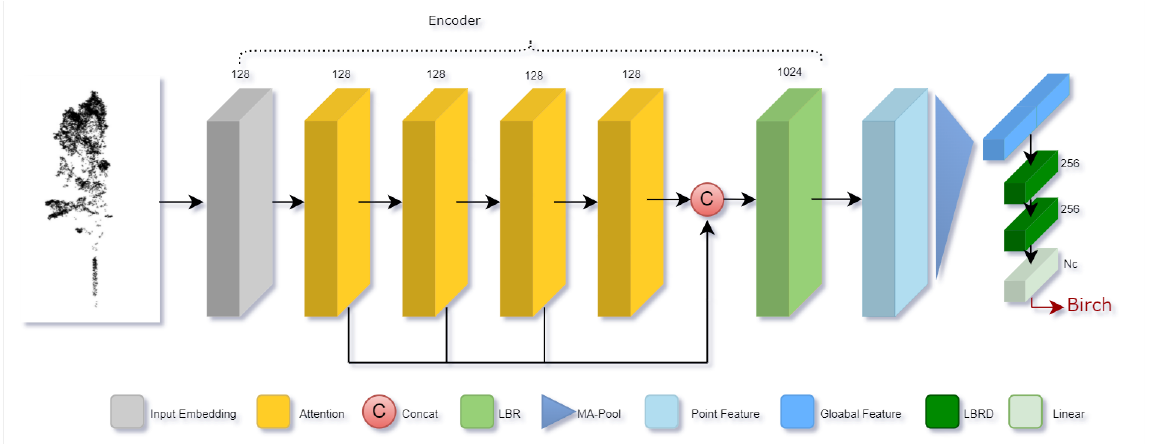
Figure 7. The architecture of PCT. LBR represents the linear layer, BatchNorm layer, and ReLU layer; MA pool layer represents the maximum pooling layer and average pooling layer; and LBRD represents the linear layer, BatchNorm layer, ReLU layer, and Dropout layer.